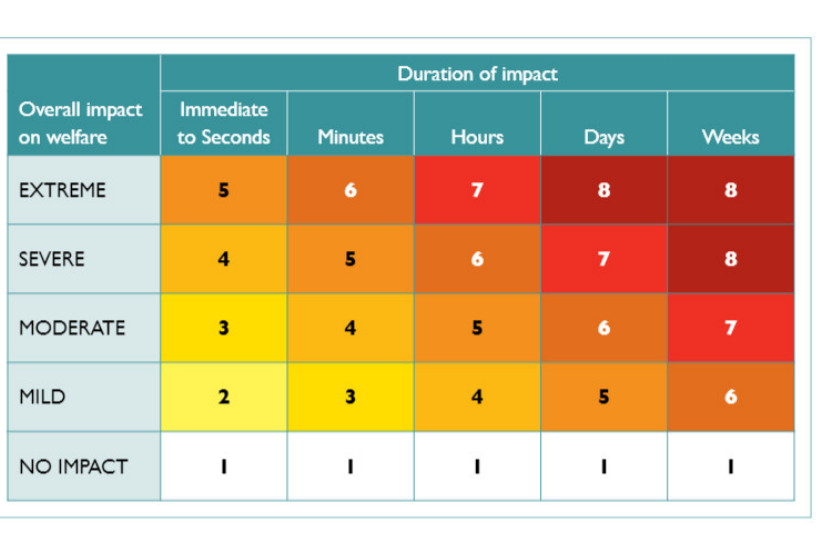
Figure A1. Overall welfare impacts of non-kill traps or of the non-lethal components of kill traps (Part A). Reprinted from A model for assessing the relative humaneness of pest animal control meth-